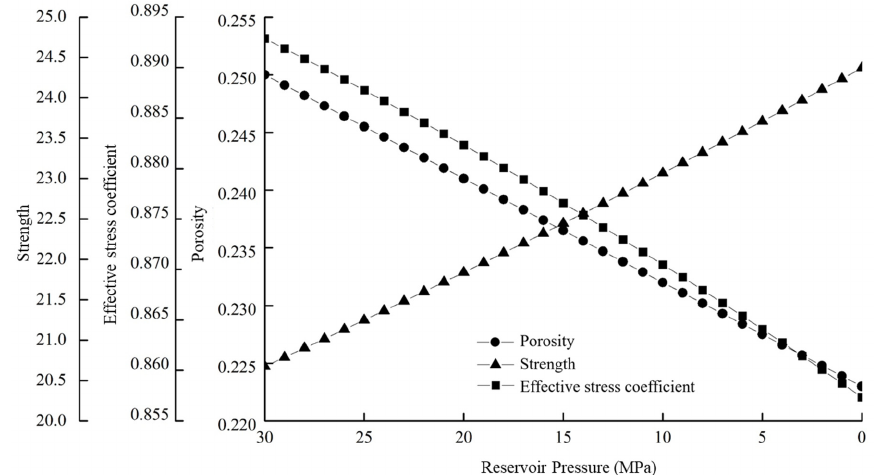
Figure 3. The evolution of reservoir pressure with adjustment wells’ position and production wells’ recovery level.